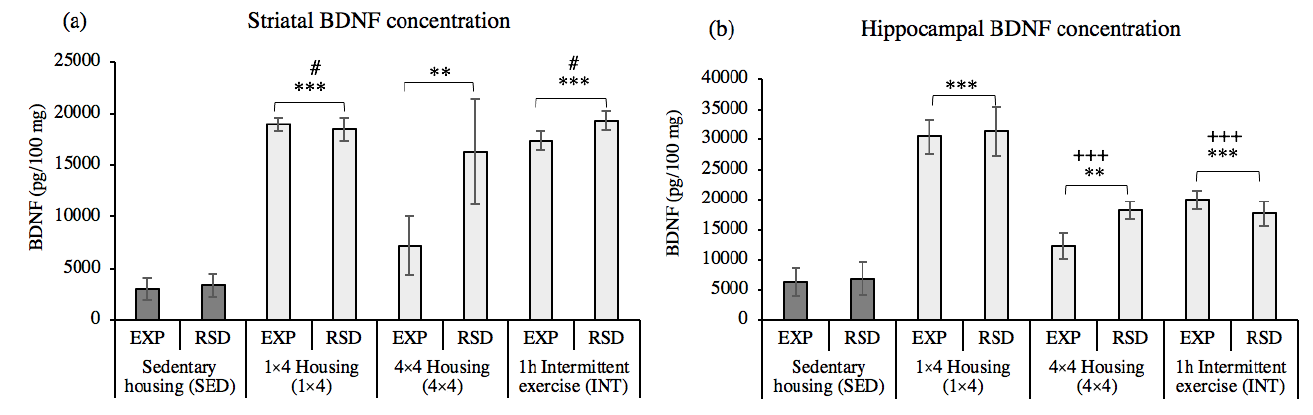
Figure 7. ( a ) Effects of voluntary wheel running on striatal BDNF levels, ( b ) Effects of voluntary wheel running on hippocampal BDNF levels. Sedentary housing (SED–EXP n = 5; SED–RSD n = 7); one activity wheel per cage (1 × 4-EXP n = 7; 1 × 4-RSD n = 6); four activity wheels per cage (4 × 4-EXP n = 9; 4 × 4-RSD n = 6); regimen of intermittent exercise (INT–EXP n = 7; INT–RSD n = 7). Data are presented as mean values of BDNF (pg/100 mg protein) ± SEM; ** p < 0.01; *** p < 0.001 significant difference in BDNF levels vs. sedentary housing (SED); # p < 0.05 significant difference in BDNF levels vs. 4 × 4; +++ p < 0.001 significant difference in BDNF levels vs. 1 × 4.